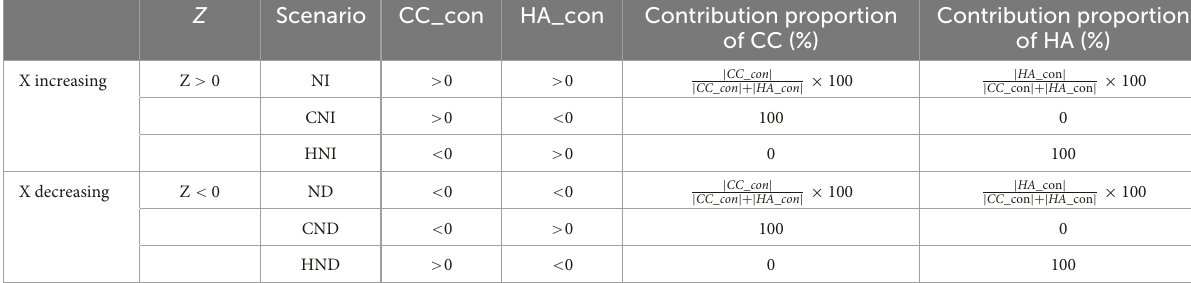
TABLE 2 Different scenarios for estimate the CC_con and HA_con to NEP increase and decrease.